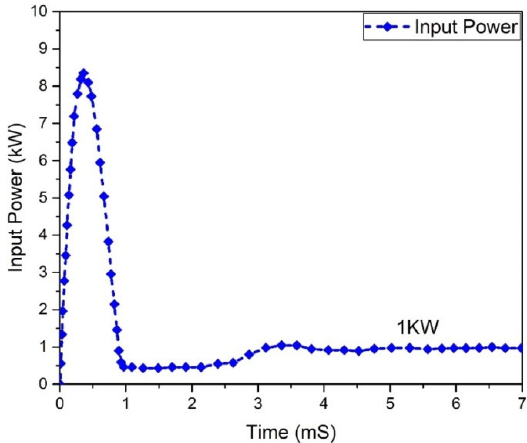
Figure 22. Input power of Flyback boost converter (GaN-HEMT).